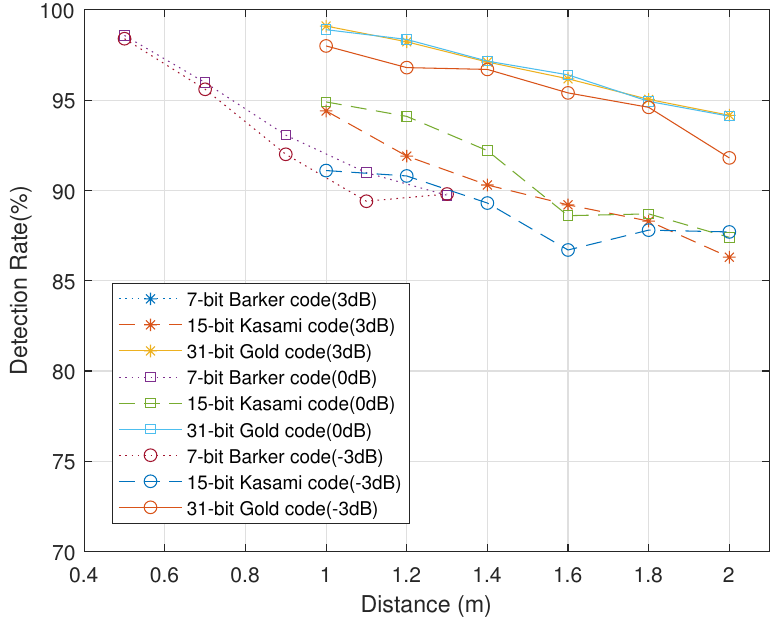
Figure 9. Detection rate on the